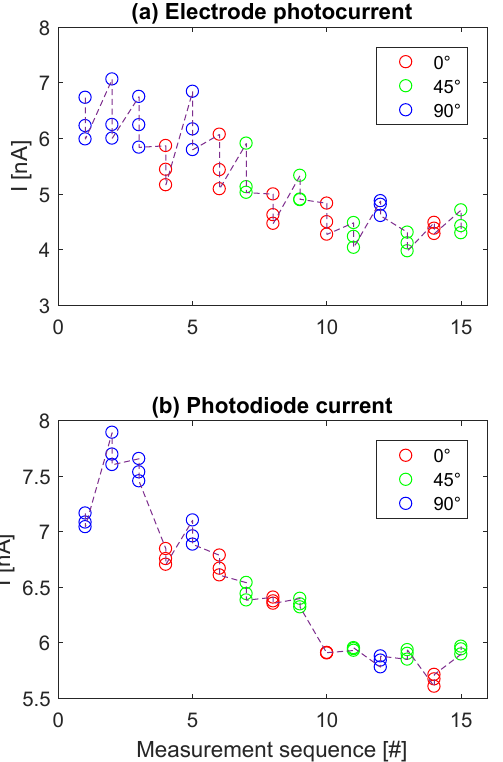
Figure 17. Results from the measurement sequences in chronolog- ical order for (a) the electrode photocurrent and (b) the photodiode current, for the three different inclinations.